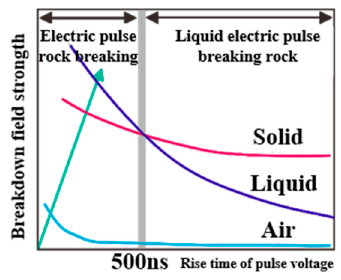
Figure 2. Relationship between breakdown field strength and voltage rise time of different dielectrics [12].